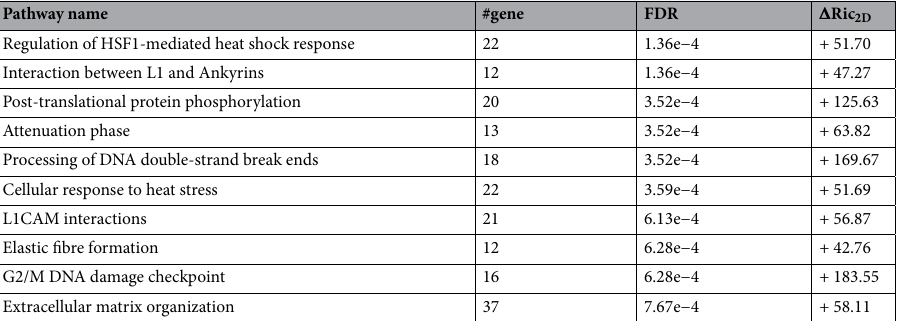
Table 2. Increased PPI curvature pathways in melanoma. Using vertex curvature of the 2D PPI network model, genes with significantly increasing curvature values compared between normal and tumor cells were fed into Reactome Pathway Analysis. Top 10 enriched pathways are summarized by pathway name, number of significant genes, false-determination rate (FDR), and average shift in curvature ( (cid:31) Ric 2D